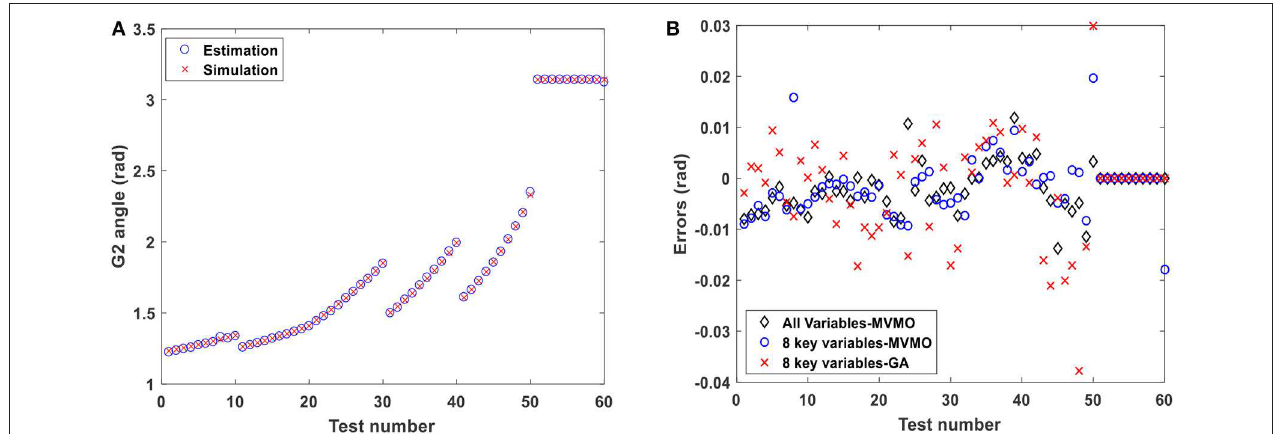
FIGURE 9 | (A) Estimation using 8 variables; (B) Errors using different amounts of variables and different methods.